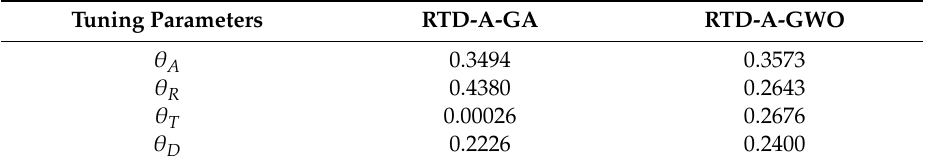
Table 4. RTD-A parameters obtained using the GA and GWO.